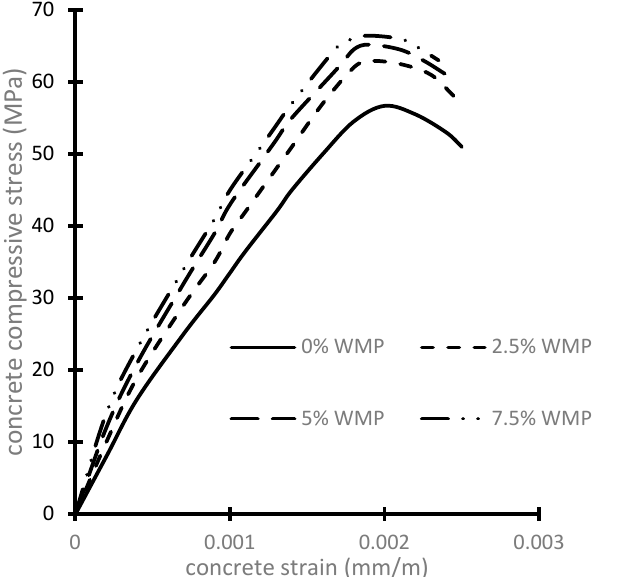
Figure 1. Concrete stress–strain relations.